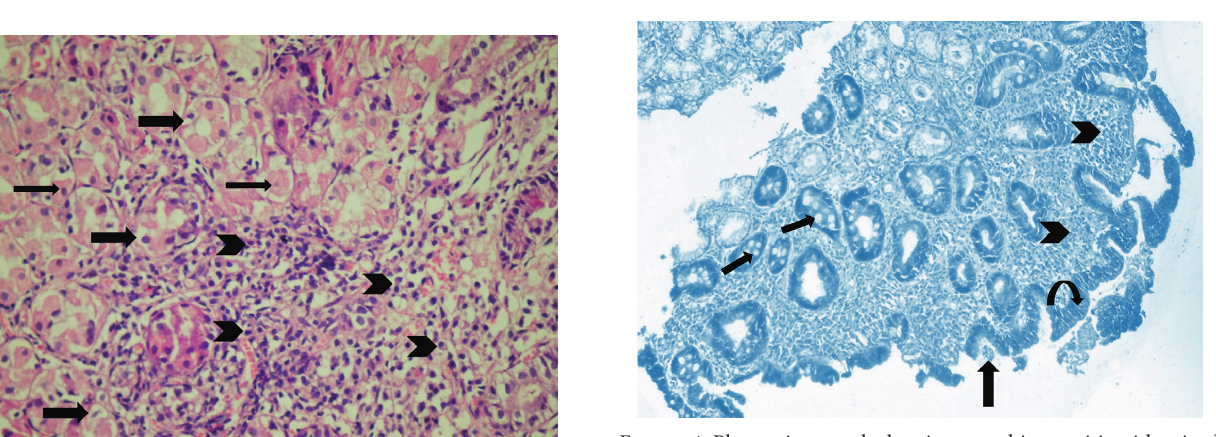
Figure 4: Photomicrograph showing atrophic gastritis with mixed inflammatory cell infiltrate (arrow heads). Helicobacter pylori are present in the superficial mucous layer (thick arrow) and intestinal metaplasia with goblet cells (thin arrow), with marked loss of mucosal glands and mucin depletion in the surface epithelium due to regenerative changes (curved arrow). Giemsa stain, ×